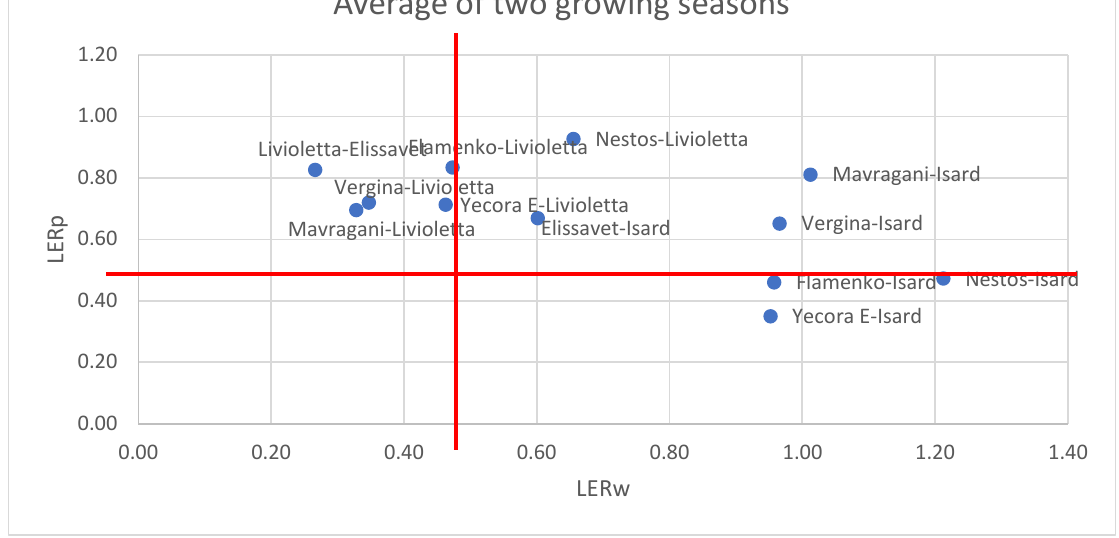
Table 5. Mean actual yield loss of wheat (AYLw), pea (AYLp), and total actual yield loss (AYL) of the different intercropping treatments.